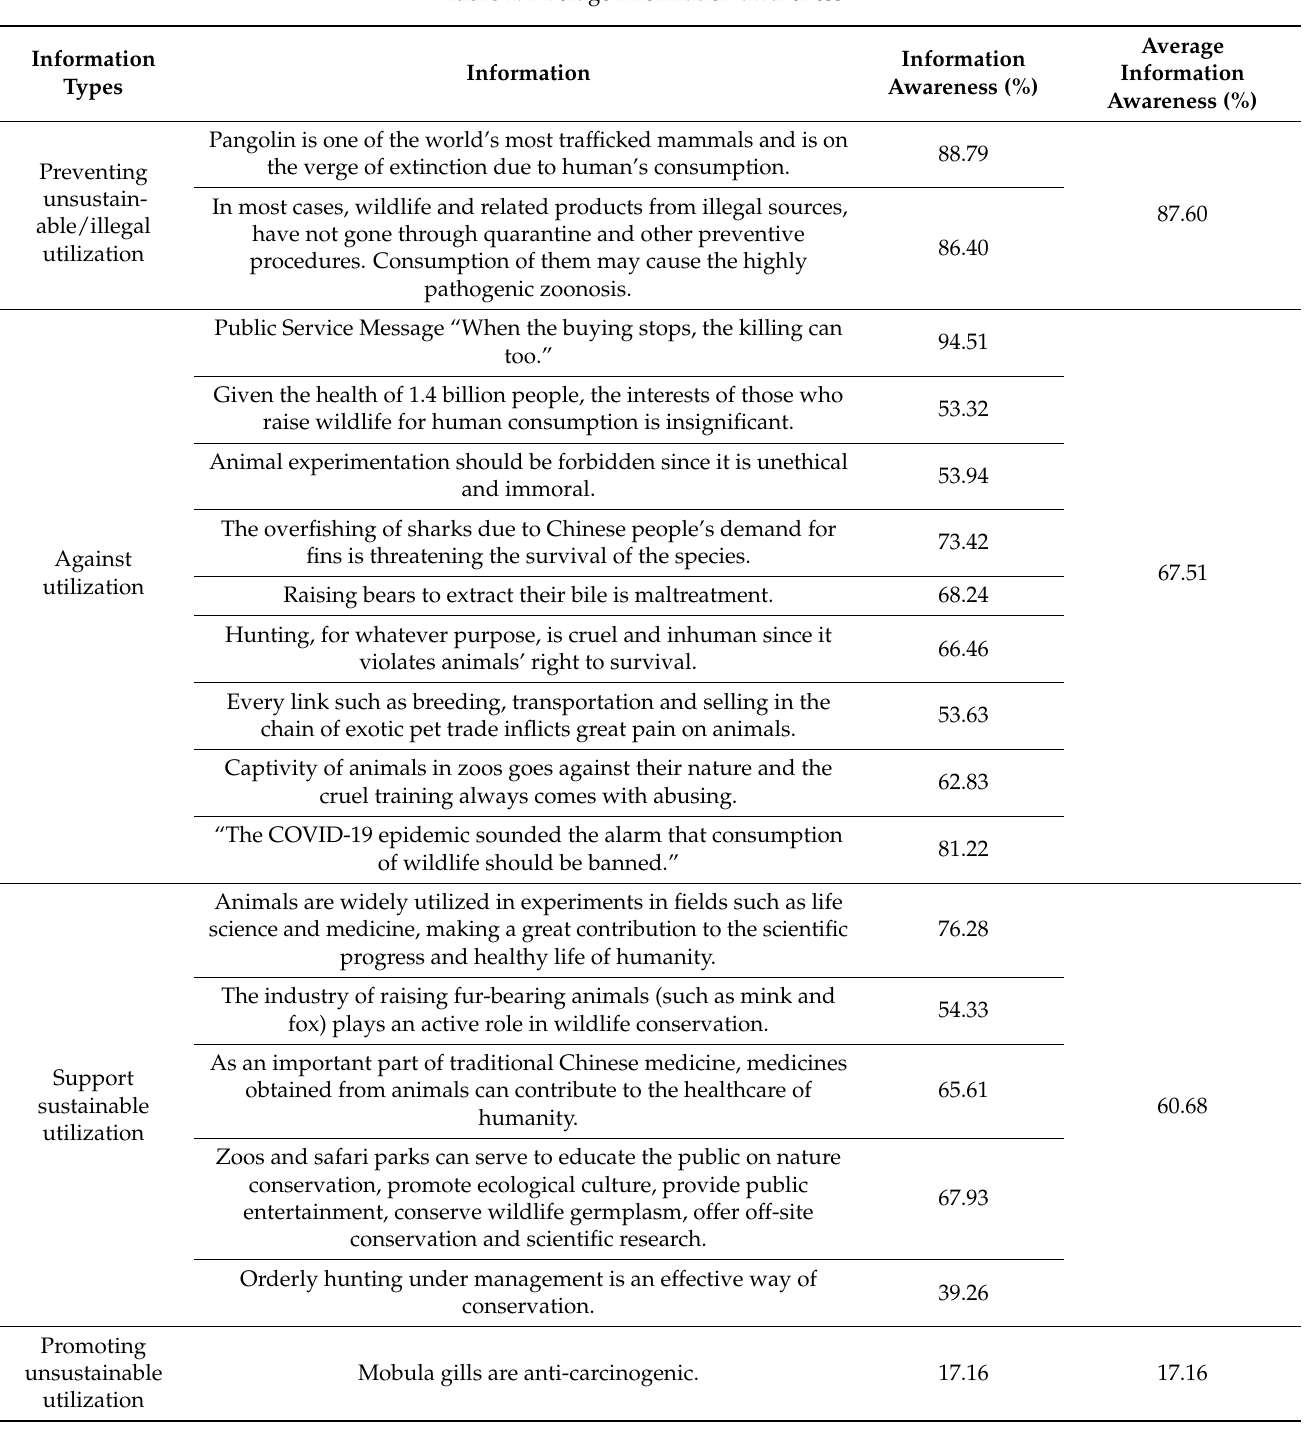
Table 1. Average information